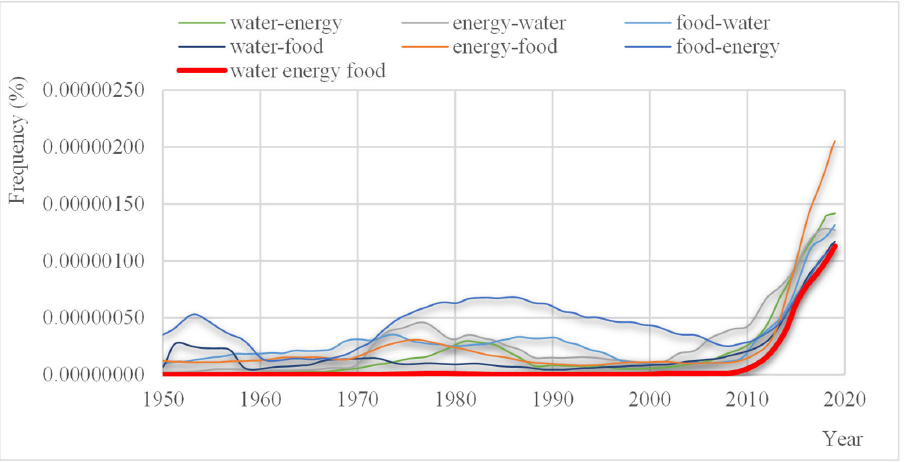
Figure 1. Frequency of appearances of the indicated phrase in Google Books up to year 2020 [20]. Data adapted graphically by Google ngrams (data from [21]).